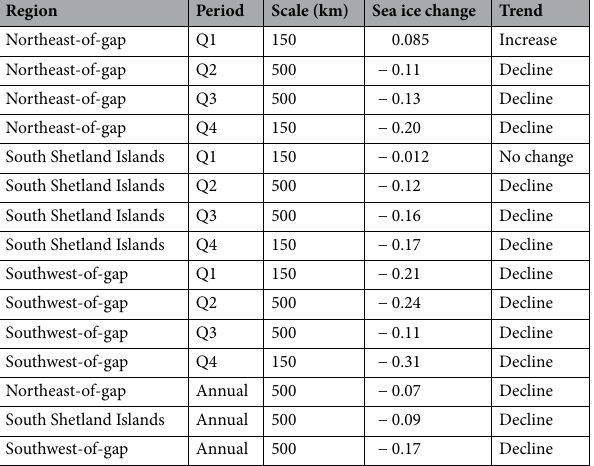
Table 3. Posterior means for for the period annual and quarterly (Q1: January-March, Q2: April-June, Q3: July-September, Q4: October-December) sea-ice concentration for the period 1979-2021. Reported trends of study regions (e.g., Northeast-of-gap, South Shetland Islands, and Southwest-of-gap) were analyzed at 150 km and 500 km spatial scales to account for seasonal differences (150 km: spring and summer, 500 km: fall and winter) in penguin foraging ranges. Bayesian posterior means are reported as Sea ice change along with associated directional